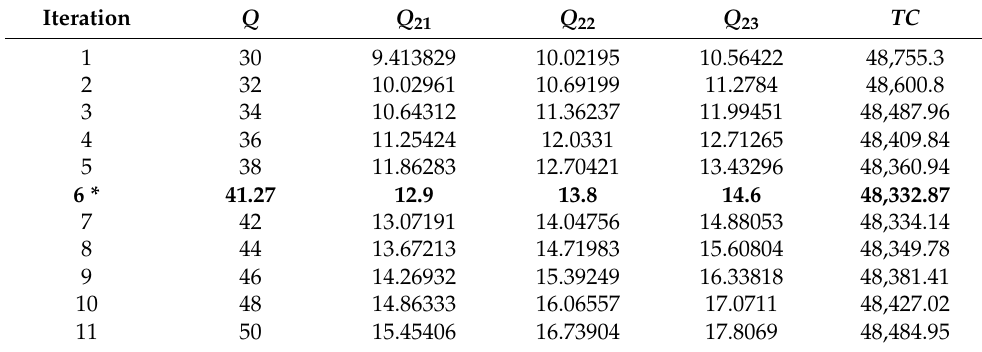
Table 6. Effect of decision variables on TC .